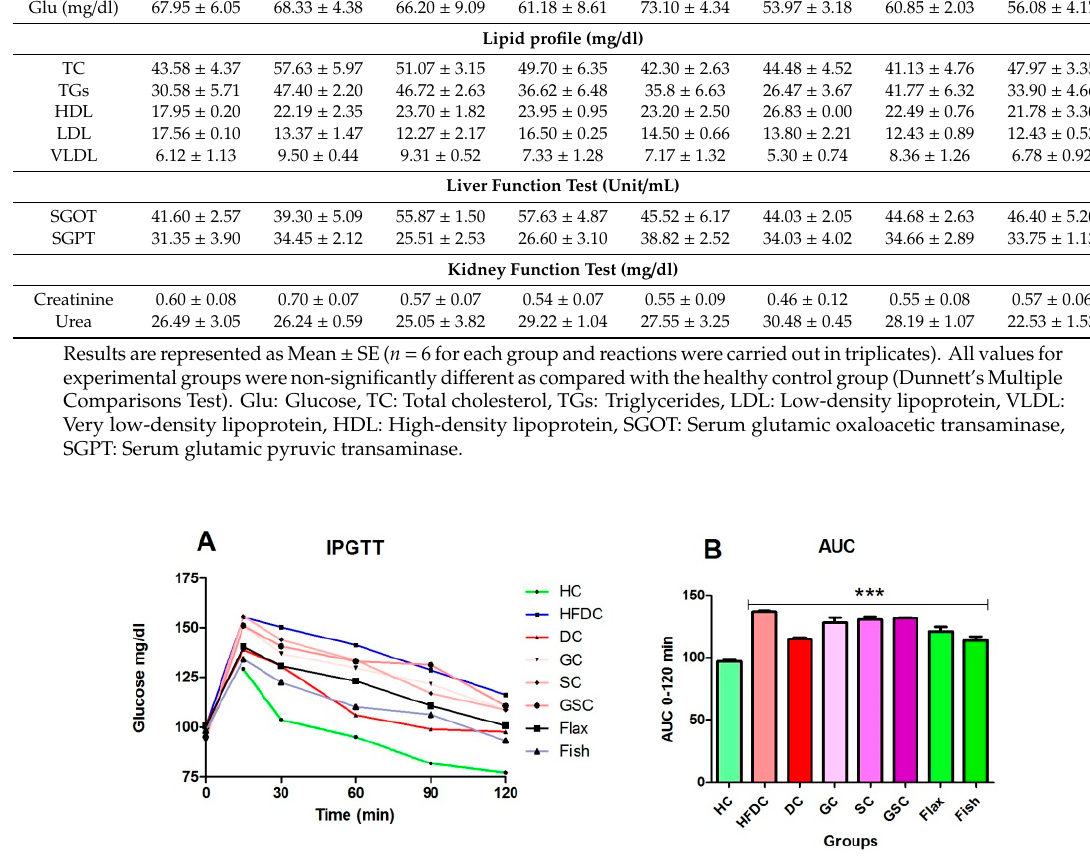
Figure 2. IPGTT and area under the curve (AUC) for the experimental groups. ( A ) Variations in blood glucose levels during IPGTT; ( B ) Area under the curve (AUC) for IPGTT. Results are represented as Mean ± SE ( n = 6 for each group). *** p ≤ 0.001, when compared with the HC animals